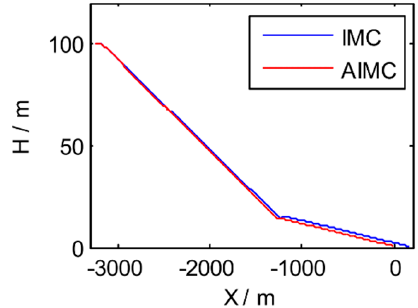
Figure 6. Height in windless condition.